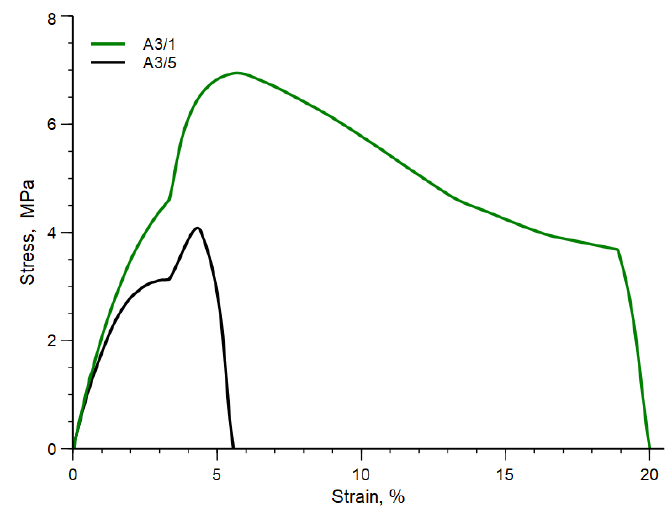
Figure 11. Stress-strain curve of A3/1 and A3/5 blends.